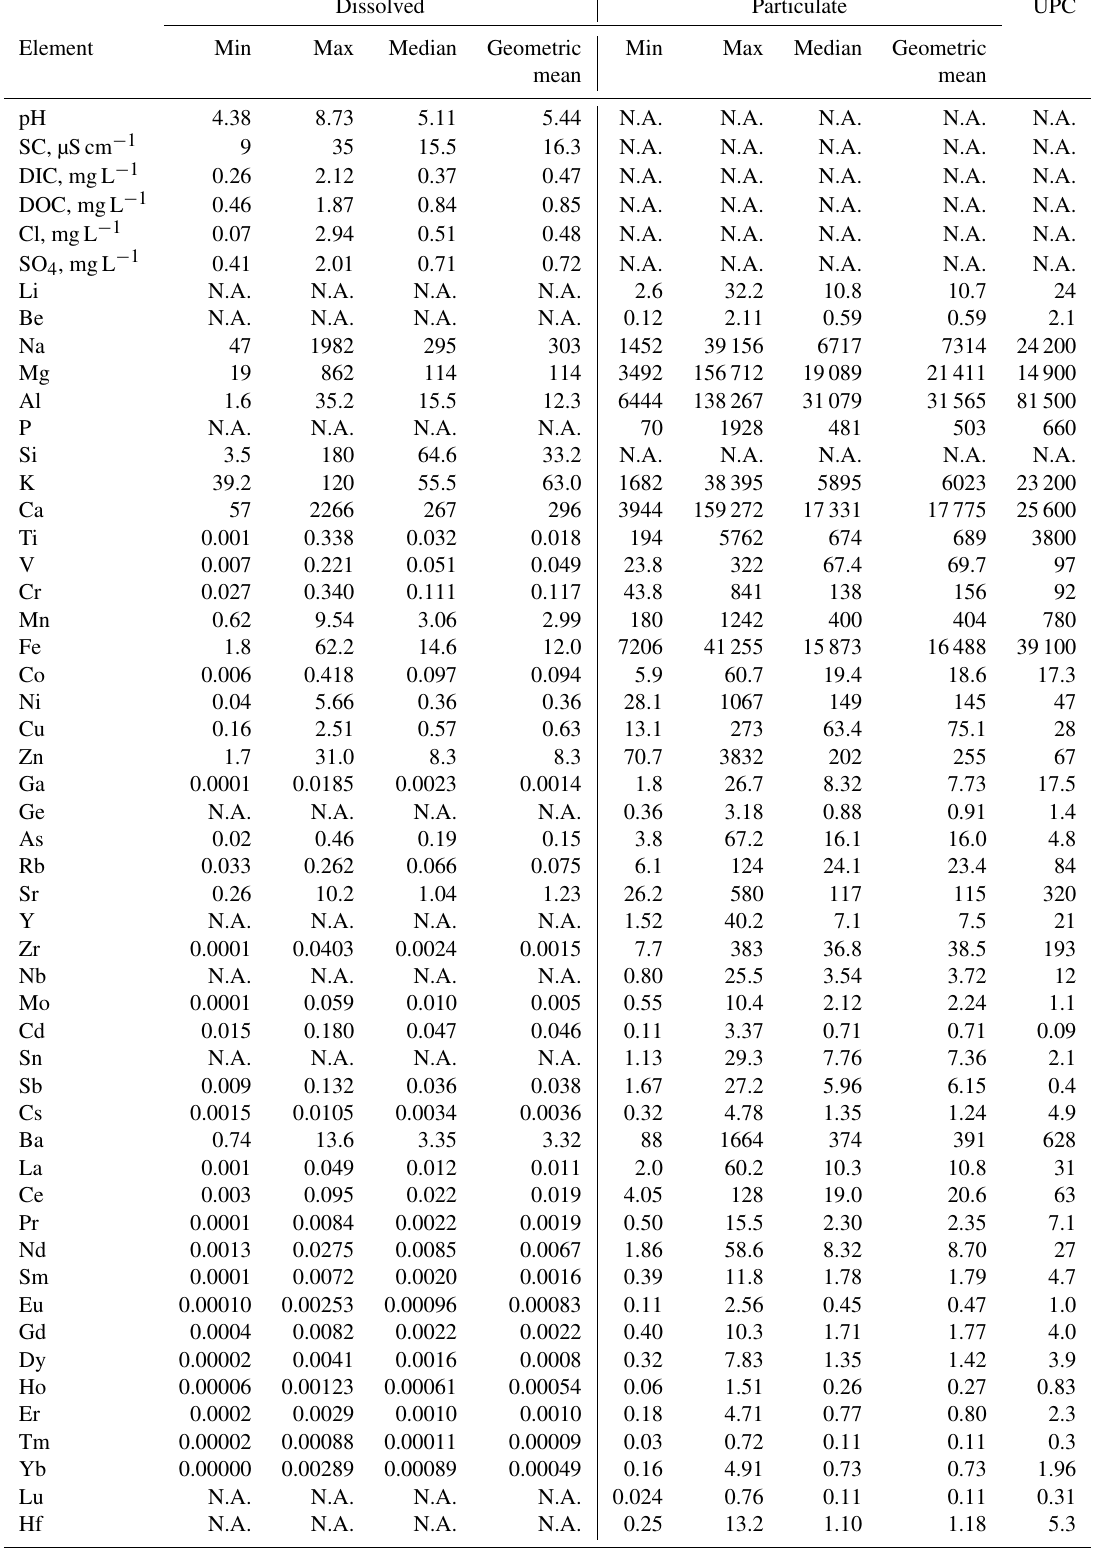
Table 1. Minimal, maximal, median and geometric mean concentration of dissolved (µgL − 1 snowwater ) , n = 35, and particulate (µgg − 1 n = 34 snow components. The data for upper continental crust (UPC) are from Rudnick and Gao (2003). N.A. stands for not